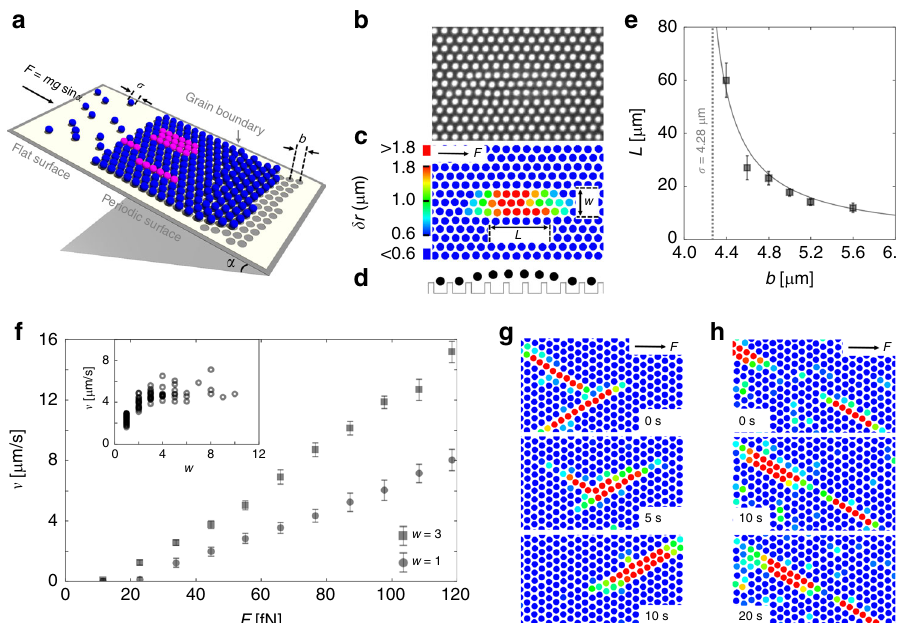
Fig. 1 Realization of interstitials in colloidal experiments. a Illustration of the experimental setup. Interstitials are formed by injecting colloidal particles into a crystalline phase on top of a patterned surface with periodic domains separated by well-de fi ned GBs. b The interstitials observed in colloidal crystals. Its crystallographic nature is shown in detail in Supplementary Fig. 3. c Same as ( b ) but with particles color coded by their distances δ r to the nearest potential minimum. d Sketch of the one-dimensional particle distribution of an interstitial over the substrate pattern. e The length L of the interstitial defects (de fi ned as those particles with δ r > 1.2 µ m) as a function of the substrate periodicity b . The dashed line indicates the size σ of the spheres. The solid line is a fi t to the equation L / σ = σ */( b − σ * ), with fi tted σ * = 4.09 ± 0.02 µ m < σ = 4.28 µ m. f The interstitial velocity v as a function of F for lateral size w = 1 and w = 3. Depinning thresholds of about 20 and 10 fN are observed, respectively. As expected of a Peierls – Nabarro barrier 26 , this threshold value is much smaller than the threshold to move isolated particles across the same pattern, see Supplementary Fig. 4 (Inset). The interstitial velocity as a function of w , with fi xed F = 45 fN. g Two w = 1 interstitials collide and merge into a w = 2 interstitial; F = 55 fN. h A moving w = 2 interstitial approaches an immobile w = 1 interstitial from behind. When they come close, the w = 2 interstitial pushes the w = 1 interstitial forward; F = 23 fN. Color code in ( g ) and ( h ) is same as in ( c ). All error bars are standard deviations of the corresponding data